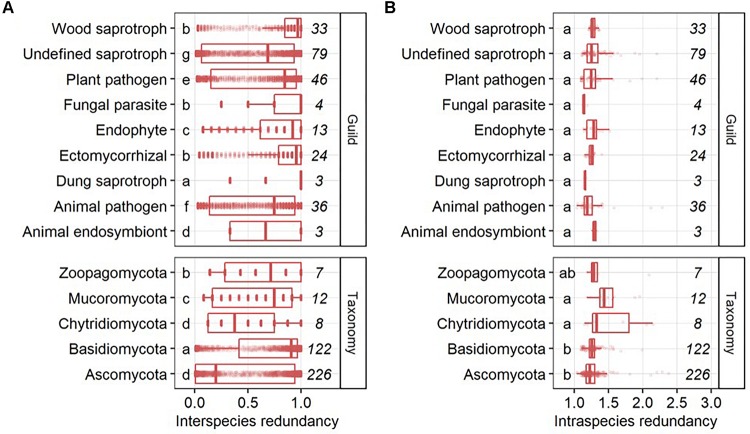
Interspecies (A) and intraspecies functional redundancy (B) in fungal guilds and phyla. The number of fungal genomes per guild and phylum is given in italic. Groups followed by the same letter are not significantly different according to the HSD test (P-value > 0.05).